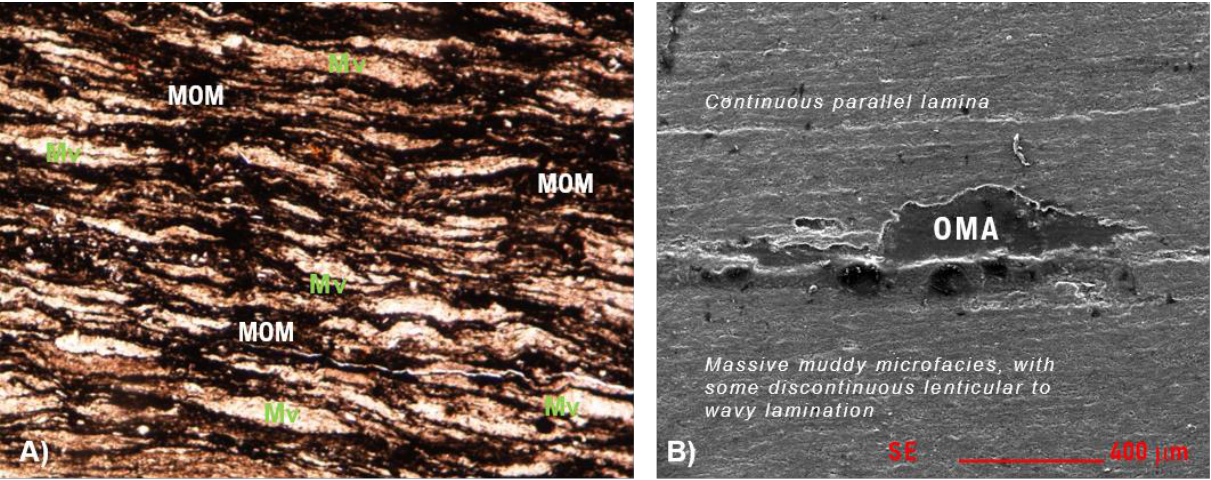
Figure 1. Granulometric complexity is identifiable only under the microscope (micro-scale level) in the mudstones of the Paja Formation. ( A ) 20X PPL petrographic microscope image: white flakes of muscovite (Mv) fine sand to silt sizes, which make up the fabric, and alternation of mats of microbiolytic organic matter (MOM, dark in the photomicrograph) with some fine light-colored siliciclasts that constitute the matrix: components are all oriented in wavy lenticular lamination. ( B ) an image of SEM secondary electron, SE, showing clay sediments (dominant size, so the rock is mud-supported) with organo-mineralogical aggregates (OMAs, sand size in the center). Note the submillimeter variation of lamination, identified